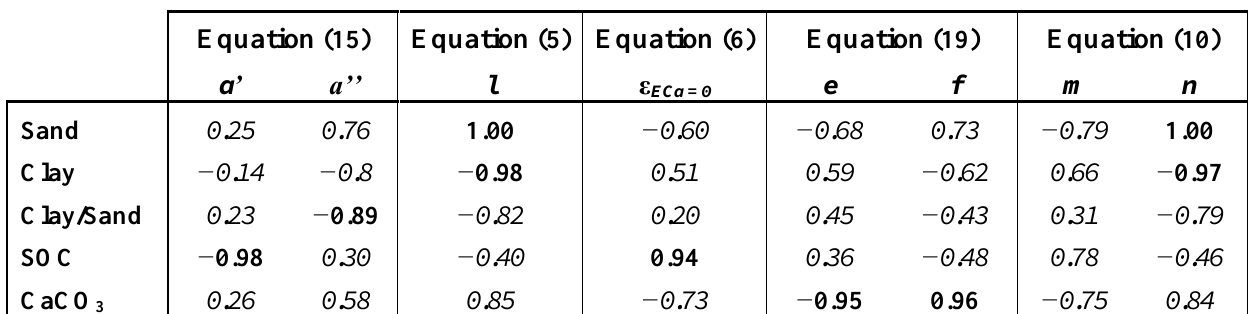
Table 3. Pearson linear correlation coefficients for some soil properties and the parameters in Equations (15) (logarithmic model), (5) (Malicki and Walczak), (6) (Hilhorst), (19) (Rhoades tortuosity) and (10) (Archie). Bold numbers indicate a significant linear